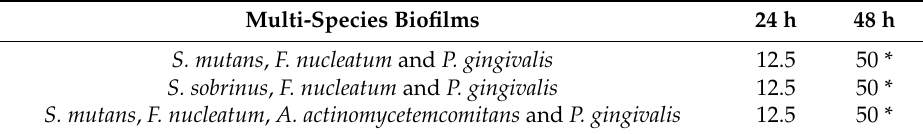
Table 3. The minimal inhibitory concentration (MIC, µ g/mL) of the mixed nanoparticles (Nano-MIX) of Nano-SB and nanoparticle-encapsulated chlorhexidine (Nano-CHX) at 9:1 ( w / w ) ratio against the selected multi-species biofilms of oral bacteria at 24 h and 48 h.